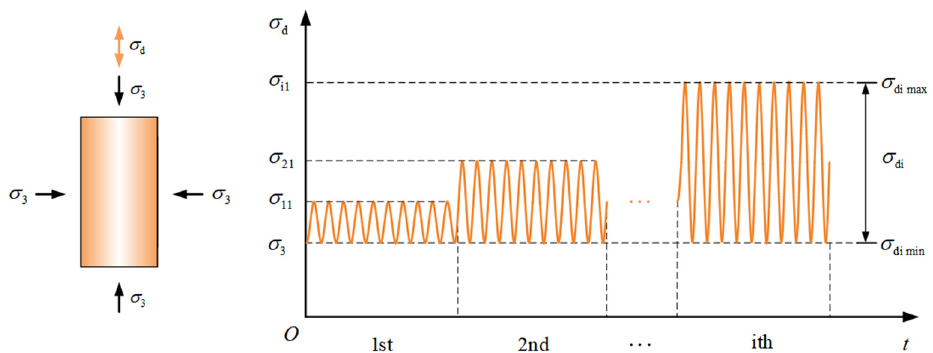
Figure 3. Application diagram of multi-stage cyclic loading.